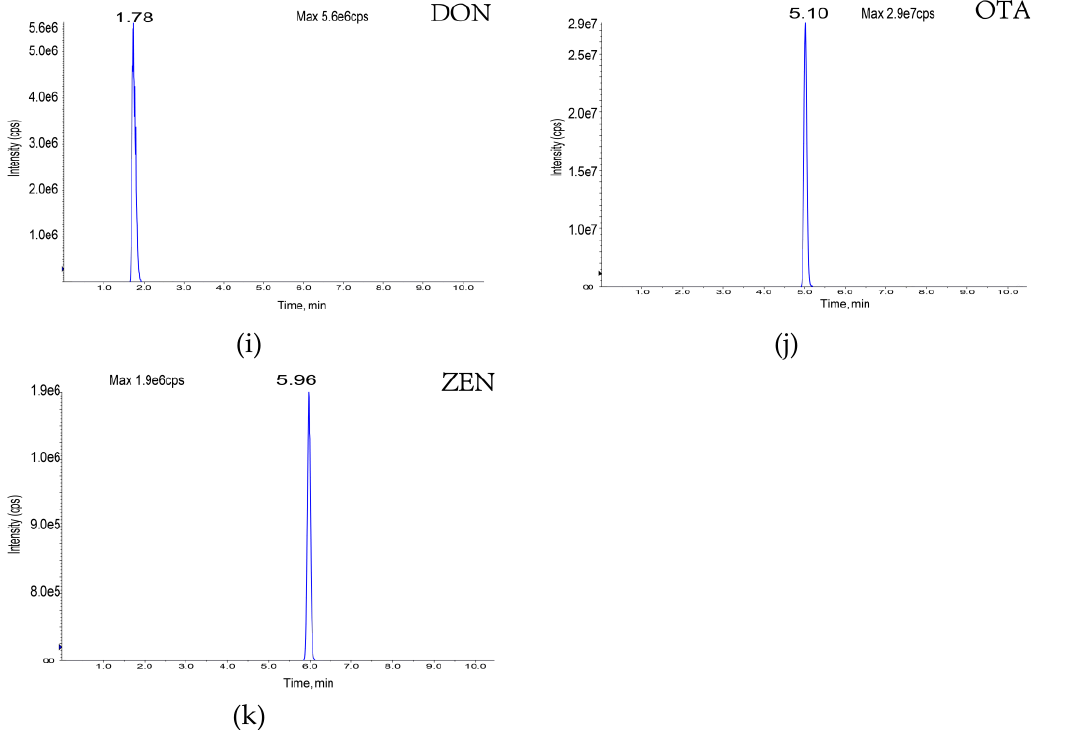
Figure 2. Eleven toxin-specific chromatograms: ( a ) aflatoxin B1; ( b ) aflatoxin B2; ( c ) aflatoxin G1; ( d ) aflatoxin G2; ( e ) T-2 toxin; ( f ) HT-2 toxin; ( g ) fumonisin B1; ( h ) fumonisin B2; ( i ) deoxynivalenol; ( j ) deoxynivalenol; ( k ) zearalenone.